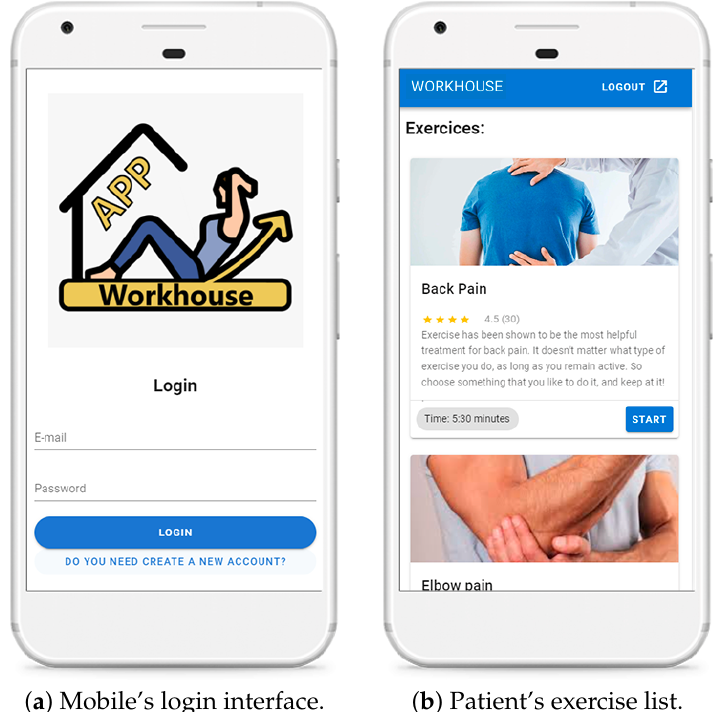
Figure 7. Mobile’s interface